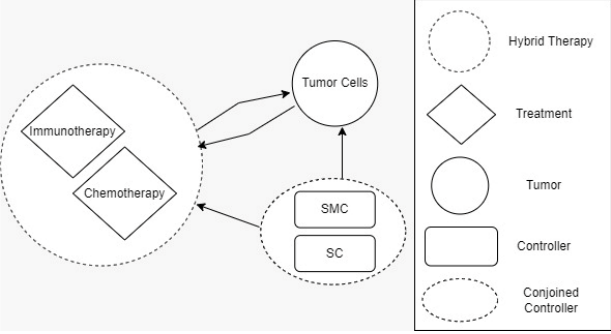
Figure 1. Three different modes for cancer-related problems.